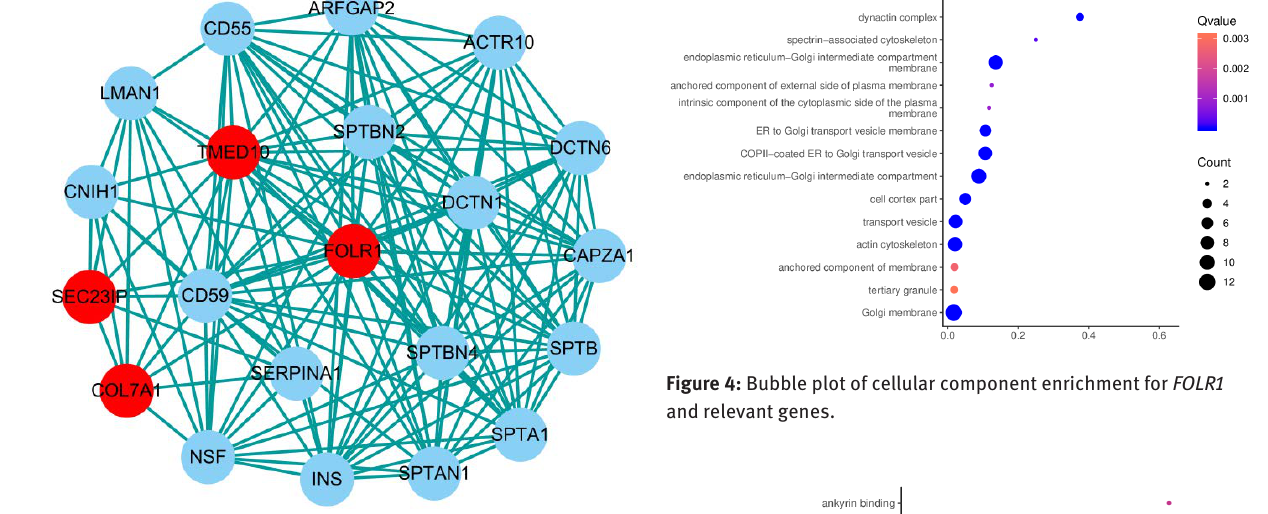
Figure2: PPI network relevant to FOLR1 and correlated genes (Red nodes indicate hub genes of the network).